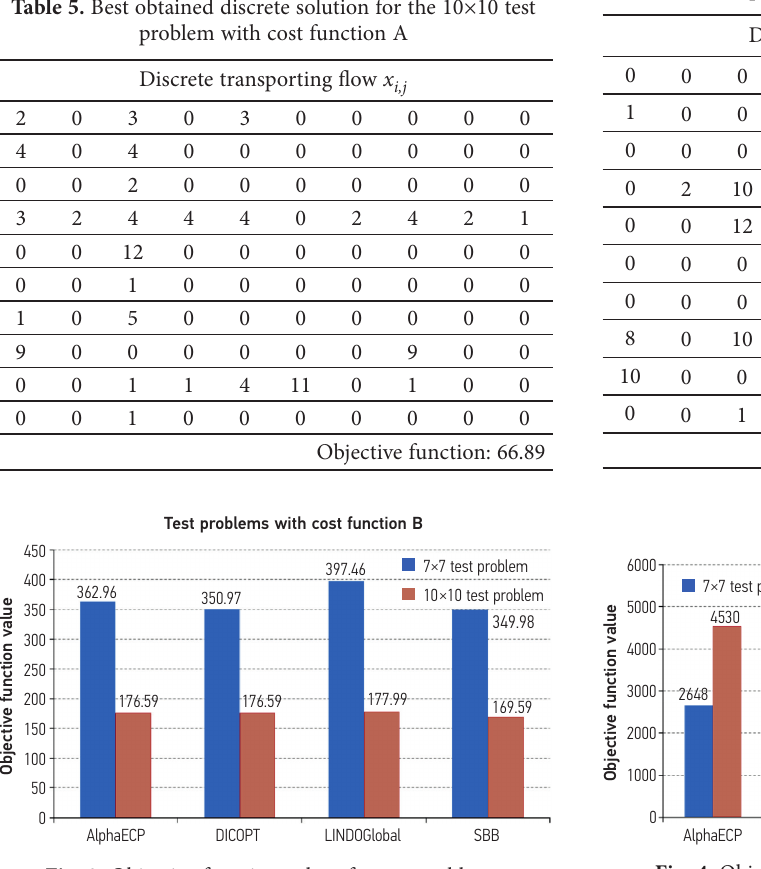
Fig. 3. Objective function values for test problems with cost function B